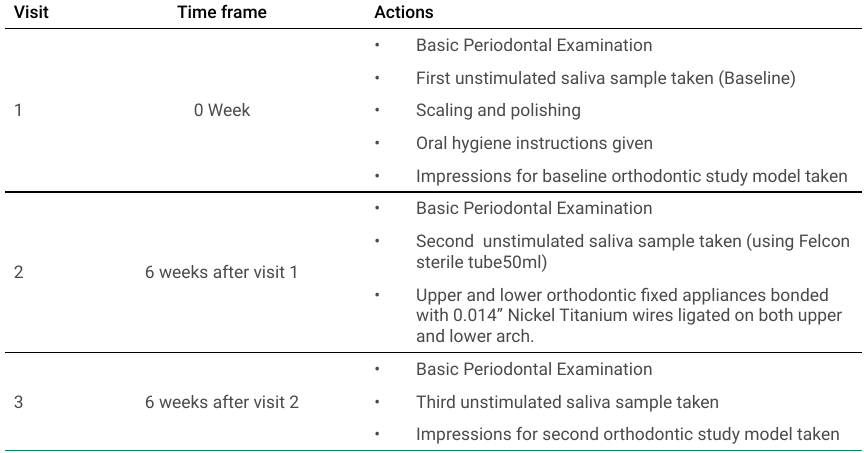
Table 1. Procedures done and time frame of the three visits.